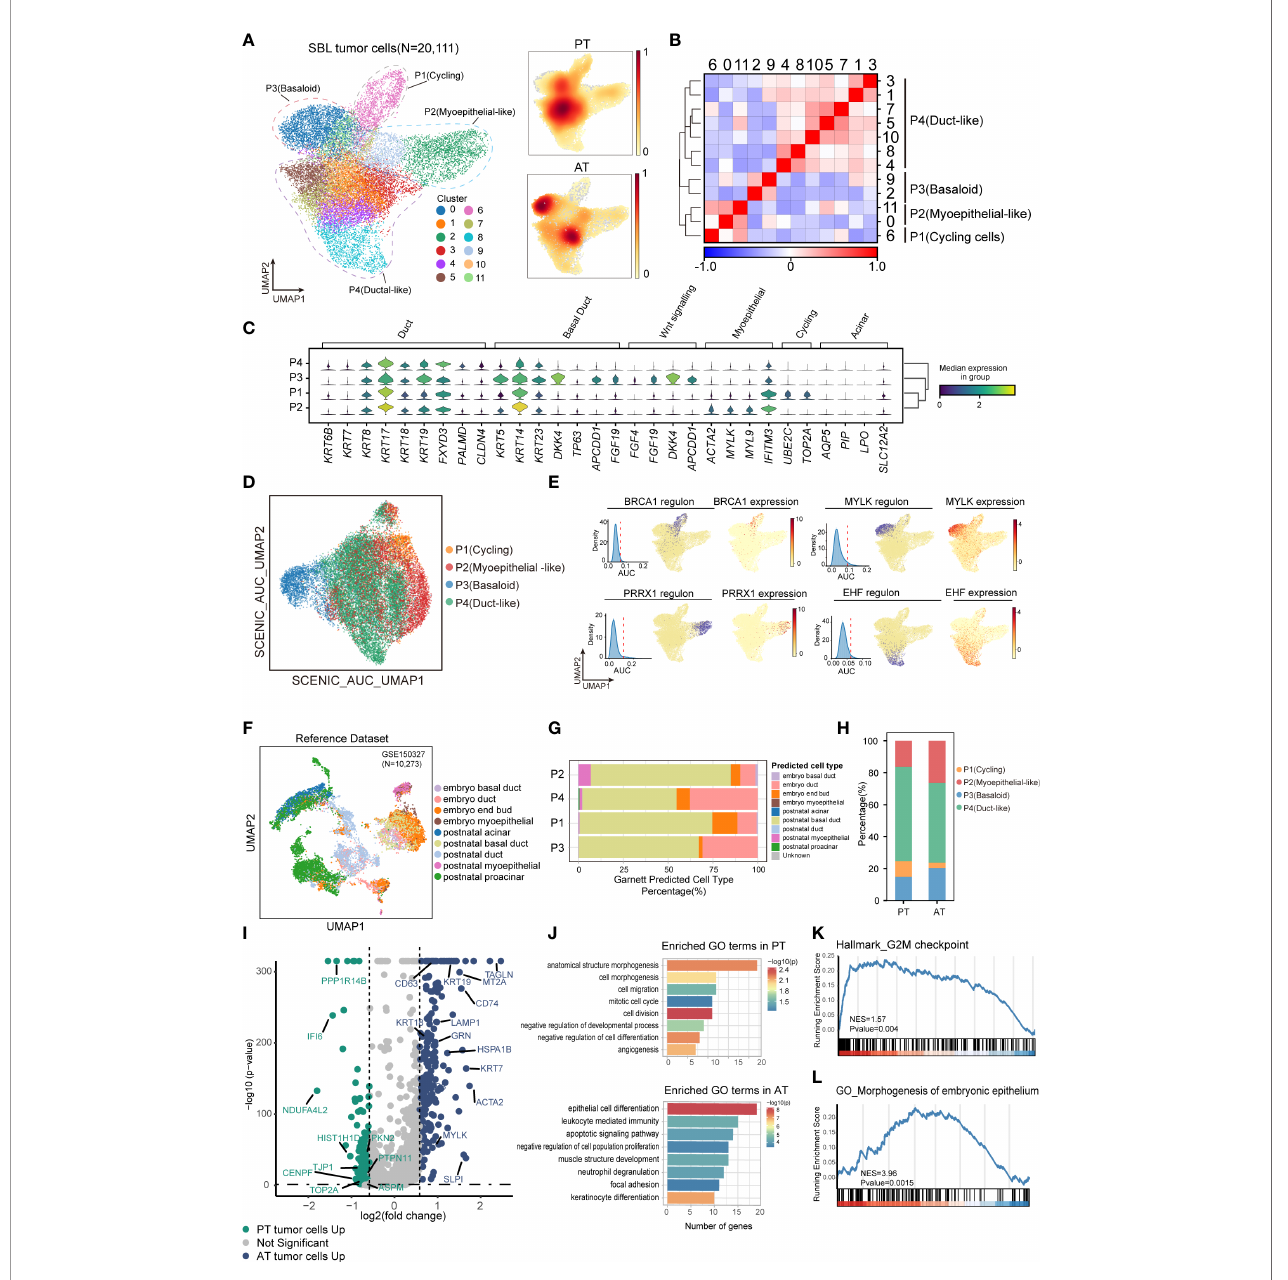
FIGURE 3 | The intratumoral heterogeneity within SBL tumor cells. (A) UMAP visualization of 20,111 tumor cells from SBL colored by clusters (left) and density of sample distribution(right). UMAP, uniform manifold approximation and projection. (B) Heatmap displaying the Pearson correlation coef fi cients calculated between average gene expressions of tumor clusters. (C) Violin plots showing the expression distribution of selected genes involved in cell cycle genes, Wnt signaling pathway, and markers speci fi c to duct, myoepithelial, basal and acinar cells in SBL tumor expression programs. (D) UMAP visualization of 20,111 tumor cells from SBL based on Scenic regulon AUC scores. AUC, area under the ROC Curve. (E) UMAP visualization of speci fi c transcription factor expression and regulon activity. For four transcription factors: (left) histogram of AUC values, together with the chosen cutoff (red dashed line); (middle)the cells with AUC value over the cutoff value are shown in purple, where the regulon is considered active; (right) the expression of the transcription factor is shown. (F) UMAP visualization of murine embryo and postnatal salivary gland datasets curated from GSE150327.Colors indicated different cell types used for Garnett classi fi er training. (G) Bar plot indicating the percentage of tumor subtypes corresponding to 9 developing cell types. Tumor cells were assigned to different identities predicted by Garnett. (H) Bar plot indicating the percentage of tumor subtypes in SBL PT and AT samples. (I) Volcano plot showing differentially expressed genes between PT (green dots) and RT tumor cells (blue dots). The names of selected important genes are indicated in the plots. (J) Bar chart showing the enrichment of GO terms, based on top50 upregulated genes in PT or AT malignant cells. GO, gene ontology. (K) GSEA enrichment plot of expression signatures of Hallmark_G2M checkpoint in SBL PT malignant cells. (L) GSEA enrichment plot of expression signatures of GO_Morphogenesis of embryonic epithelium in SBL AT malignant cells. SBL, sialoblastoma; PT, primary tumor; AT, tumor after